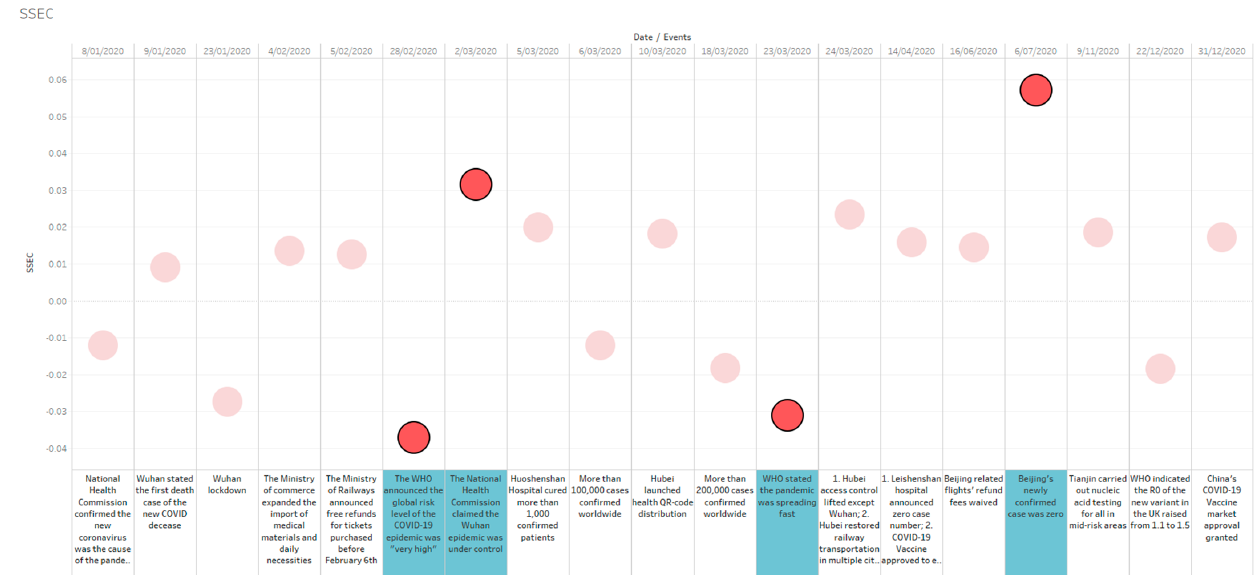
Figure 4. SSEC’s trends on relevant social events.